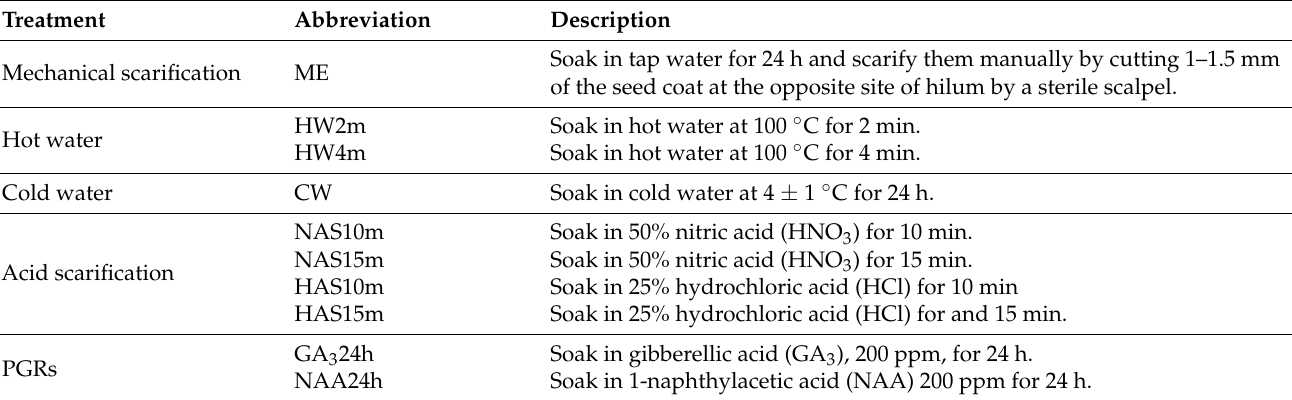
Table 1. Summary of black cardamom seed